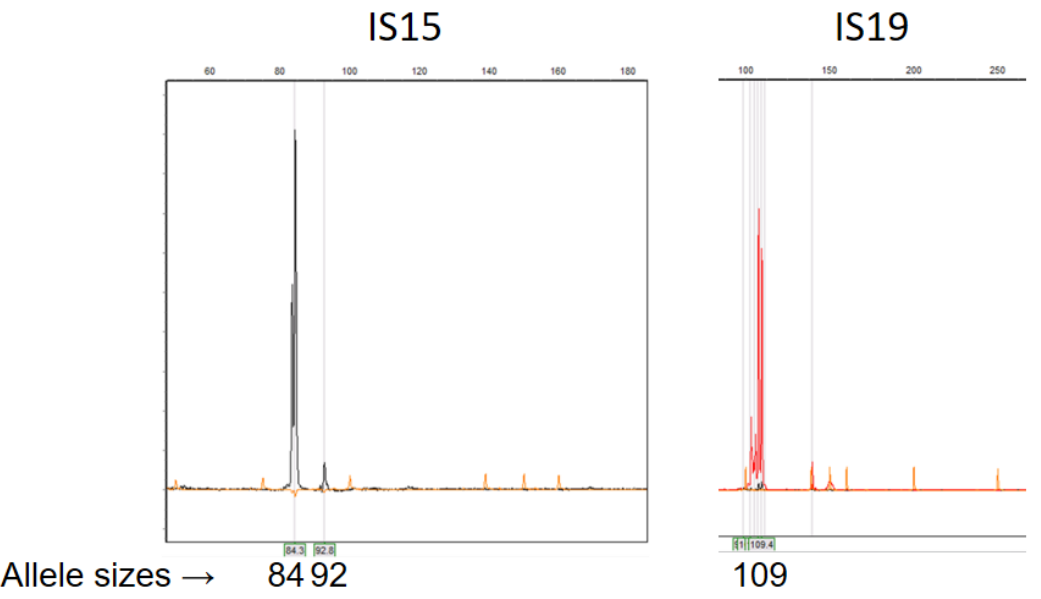
Figure 4. Examples of an initially dismissed micro-peak that produced SAD at locus IS15 (the peak for allele 92 appears much smaller than for allele 84) and of stuttering at locus IS19 (stutters around allele 109 hides the possible presence of allele